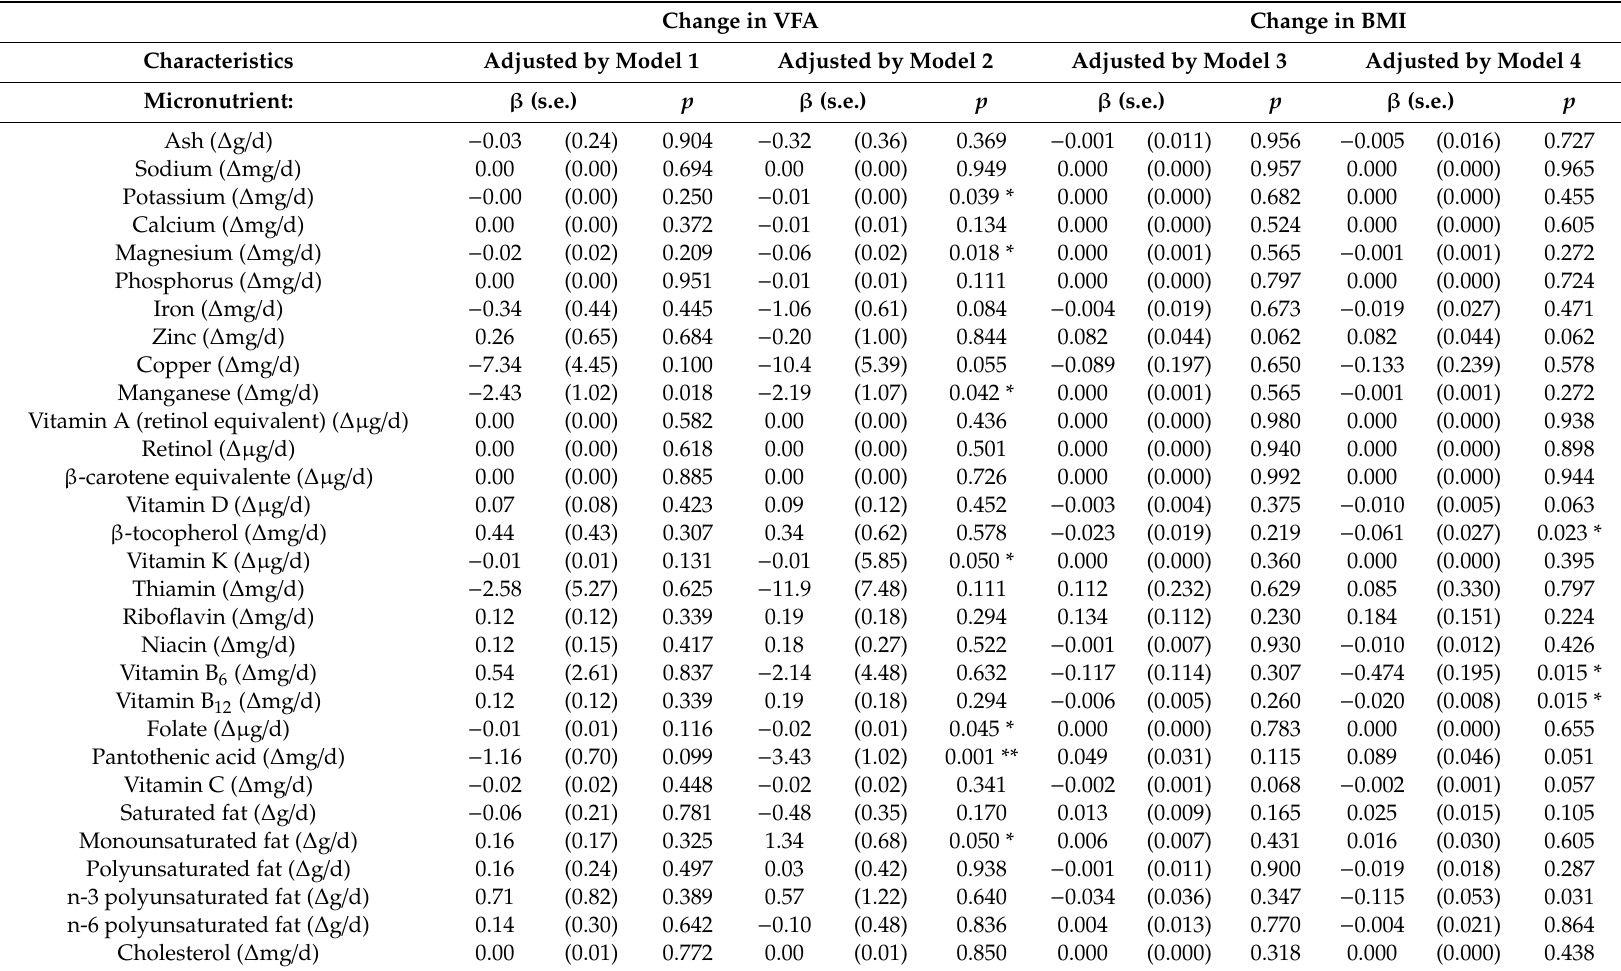
Table 4. Association between VFA and micronutrient change over 2